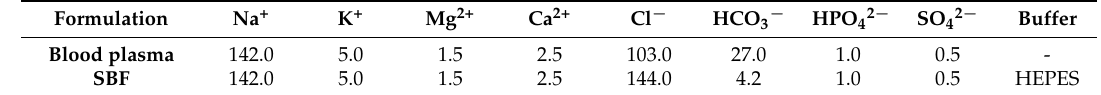
Table 1. Simulated body fluid (SBF) composition.